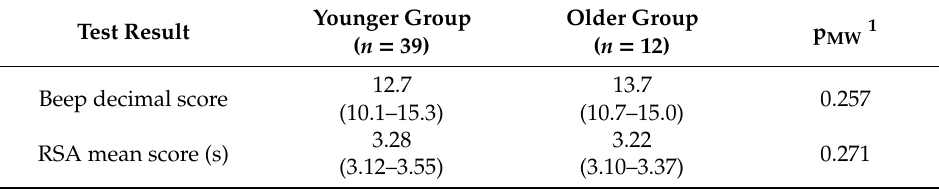
Table 2. The results of the tests performed by the participants.